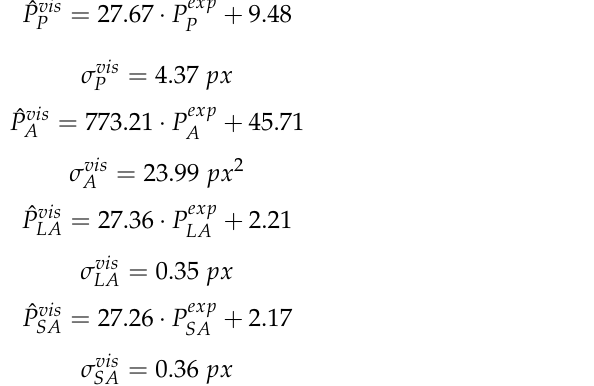
Figure 6. Repeatability of the system, in terms of the standard deviation, 𝜎 % (𝑃 𝑖 ) , of 𝑃 𝑖,𝑞 ( q for 10 repetitions) for each operating condition (two considered particle shapes and dimensions): ( a ) pe- rimeter, ( b ) area, ( c ) long and ( d ) short axes.